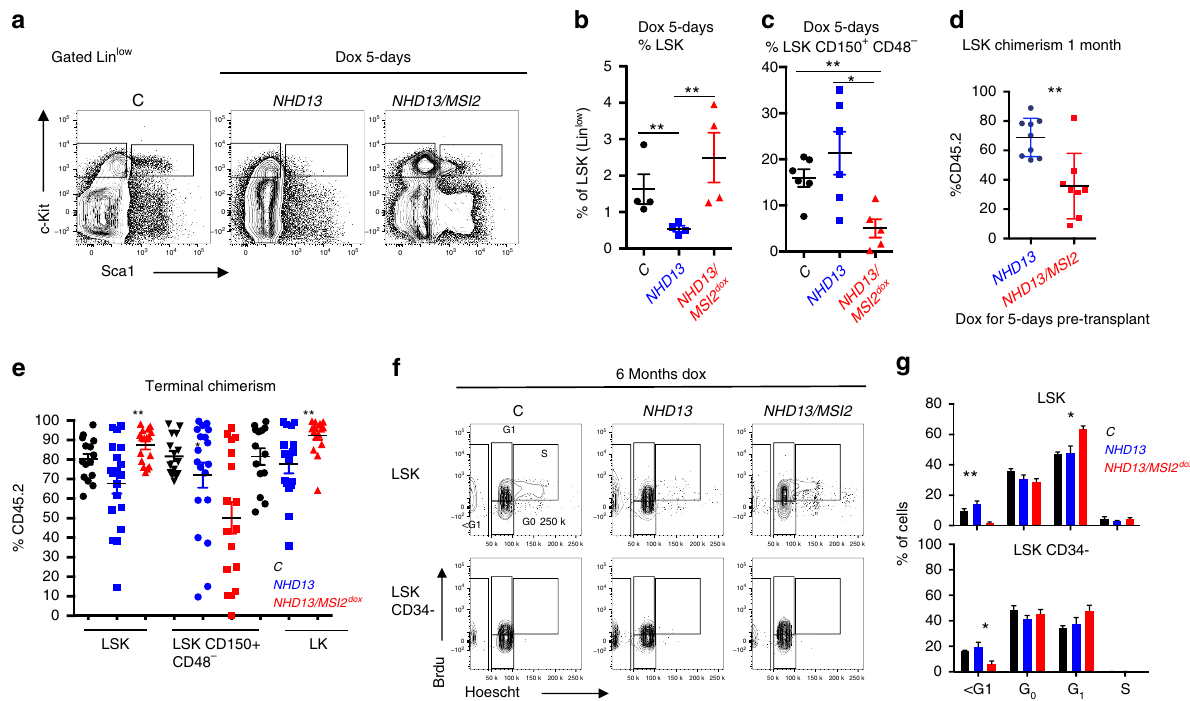
Figure 4 | MSI2 overexpression leads to haematopoietic progenitor stem cell expansion. ( a ) Representative flow cytometry of primary animals treated with doxycycline (Dox) for 5 days and live and Lin (cid:2) gated. ( b ) Percentage of LSK population among the Lin low compartment from primary mice (C; NHD13 and NHD13/MSI2 Dox ; n ¼ 6, n ¼ 6 and n ¼ 5 from five independent experiments). ( c ) Percentage of the HSC (LSK þ CD150 þ CD48 (cid:2) ) compartment gated from the LSK þ (C; NHD13 and NHD13/MSI2 Dox same as b ). ( d ) Chimerism (CD45.2) in the LSK compartment at 1 month transplantation after 5 day dox administration in the primary animals, data representative of two independent transplants ( NHD13 ; n ¼ 9, NHD13/MSI2 Dox ; n ¼ 8), ( e ) Terminal chimerism from transplants in Fig. 3 in the